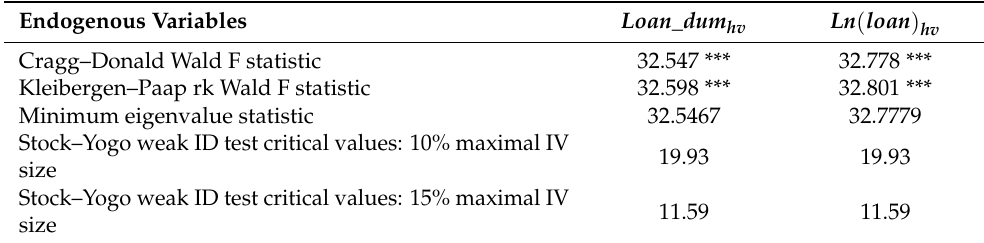
Table 5. Weak instrumental variable